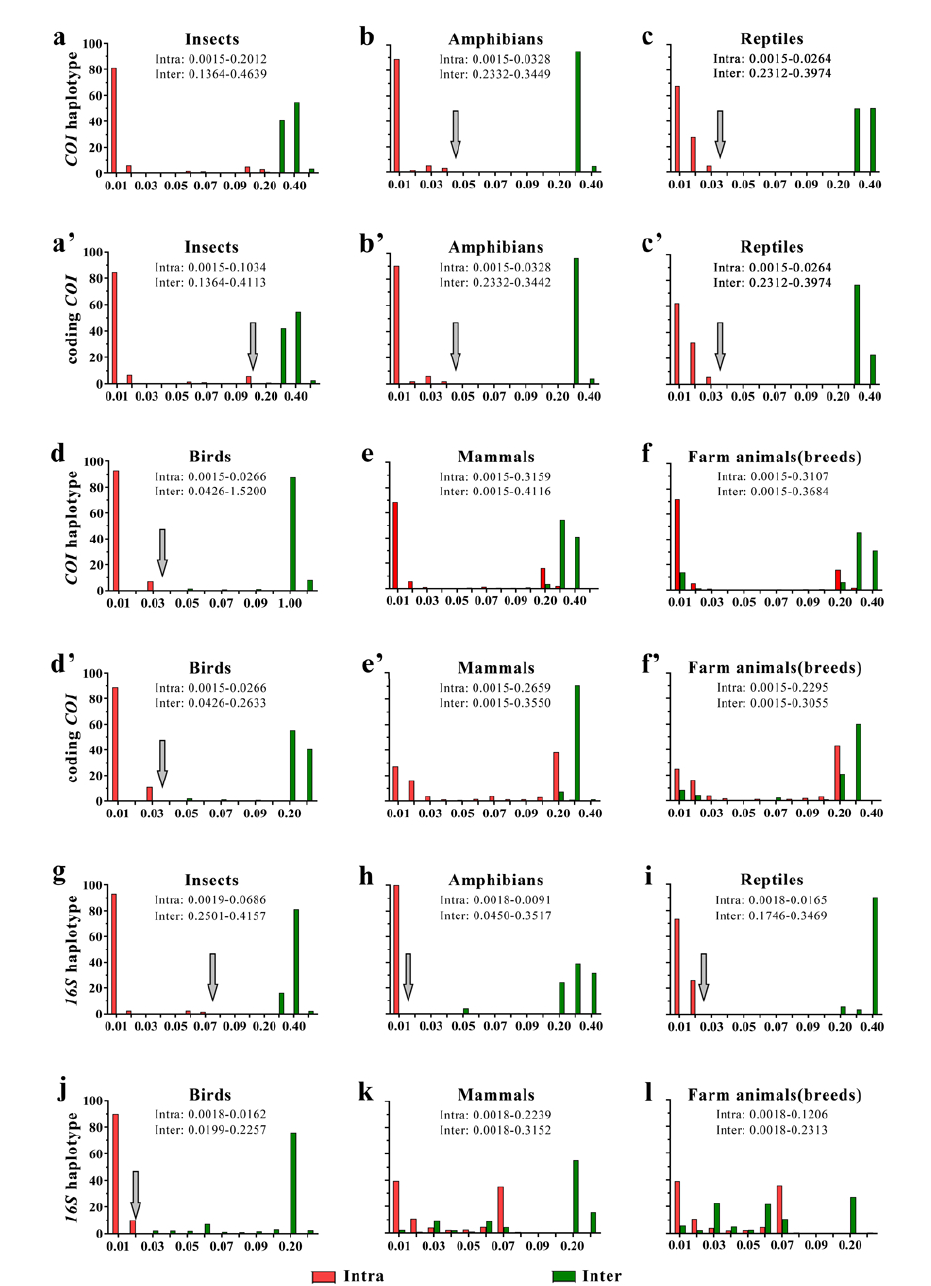
Figure 4. Histograms displaying the intraspecific and interspecific K2P pairwise sequence divergences for all COI haplotypes (a-e), coding COI (a’-e’) and all 16S haplotypes (g-k) of animal classes as indicated. Genetic distances are also compared within and between the 14 breeds of farm animals with COI haplotypes (f), coding COI (f’) and 16S (l) haplotypes. The minimum and maximum inter/intraspecific distance is depicted for each comparison. Gray arrows indicate the existence of barcoding